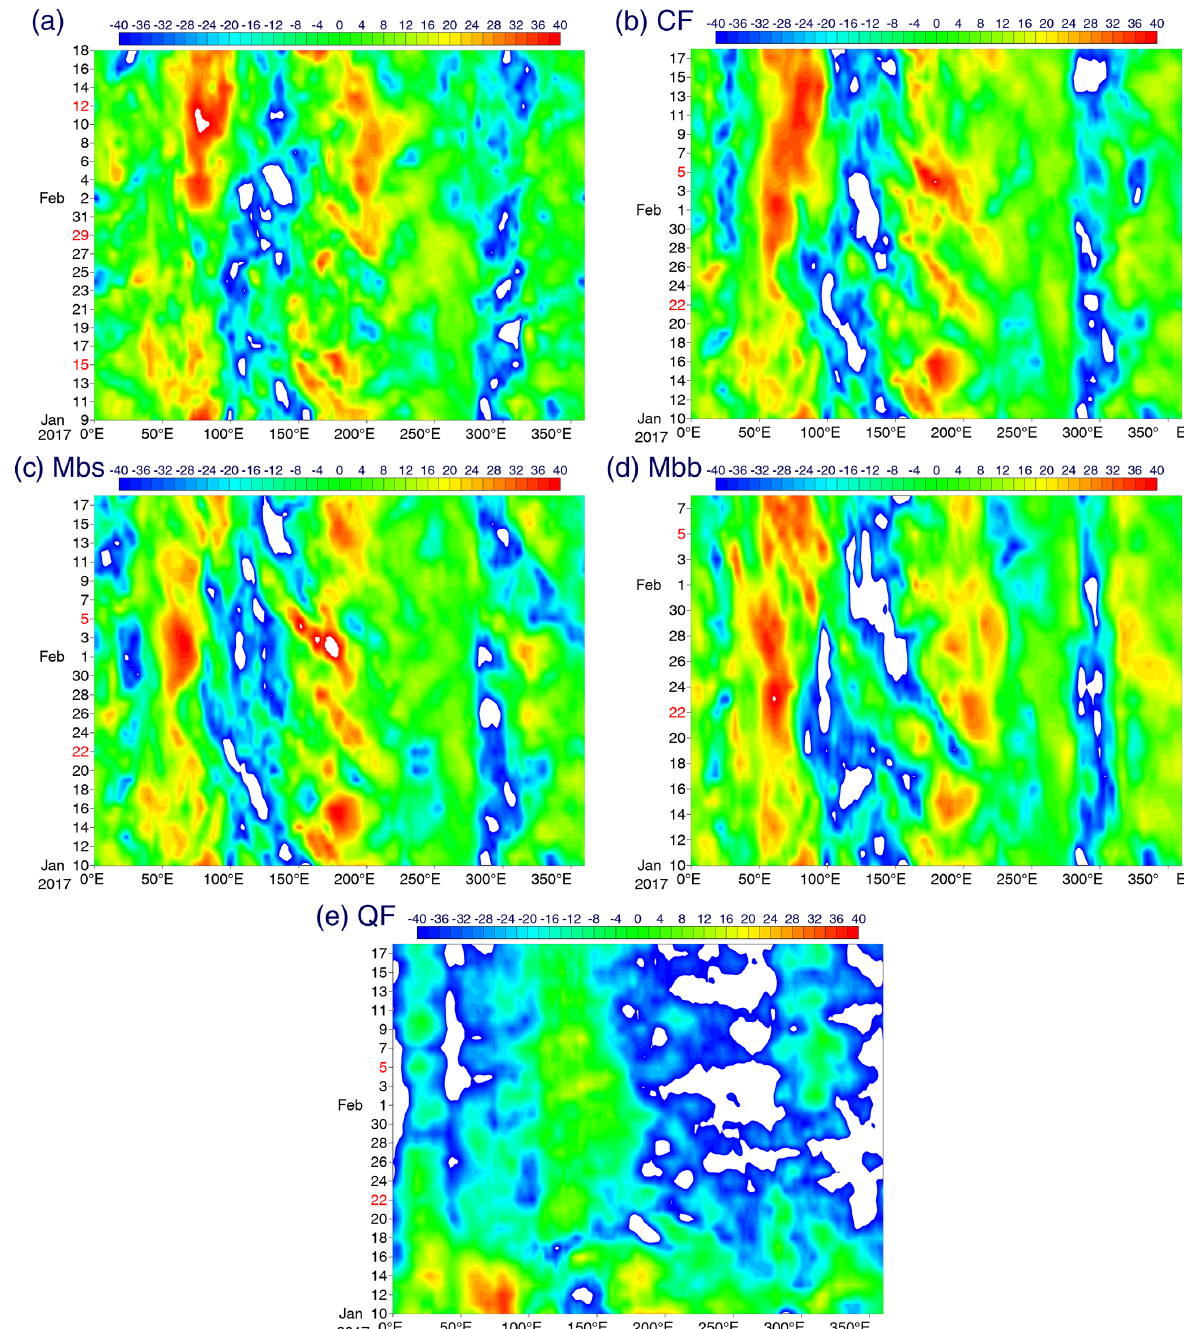
Figure 4. Time–longitude sections averaged over 15 ◦ S–15 ◦ N of OLR for the 40d extended forecast case: (a) analysis, (b) CF, (c) Mbs, (d) Mbb and (e) QF. Note that the Mbb case (d) is an exception and only runs for